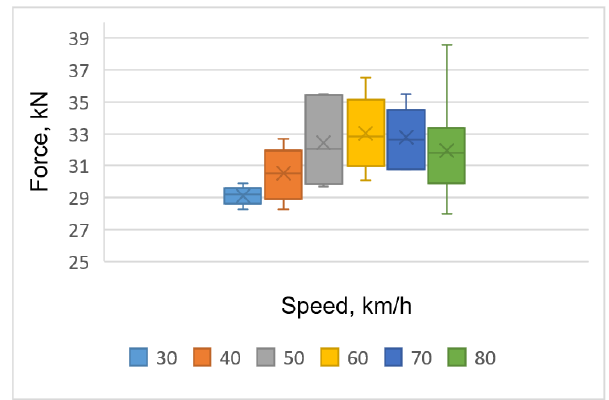
Figure 17. Vertical force mean values of unloaded wagon.